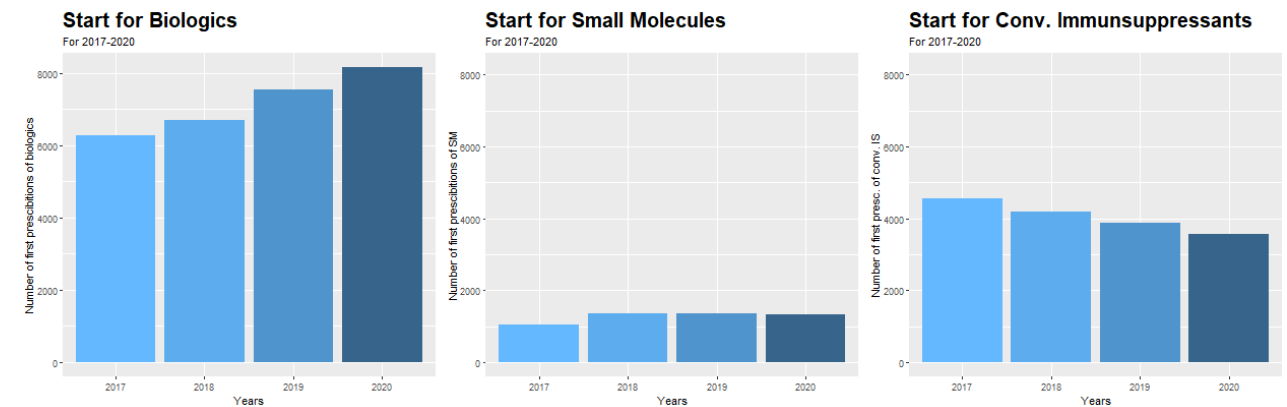
Figure 3. Annual starts for biological medications, small molecules, and conventional immunosup- pressive medications in the period 2017–2020.